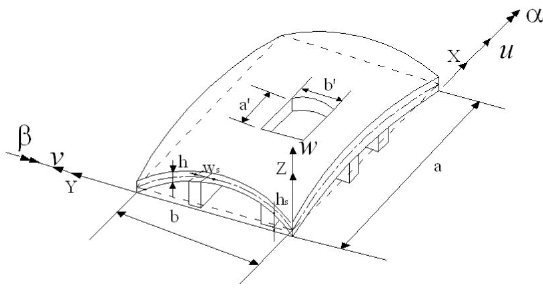
Figure 1: Elliptic parabolic shell with a concentric cutout stiffened along the